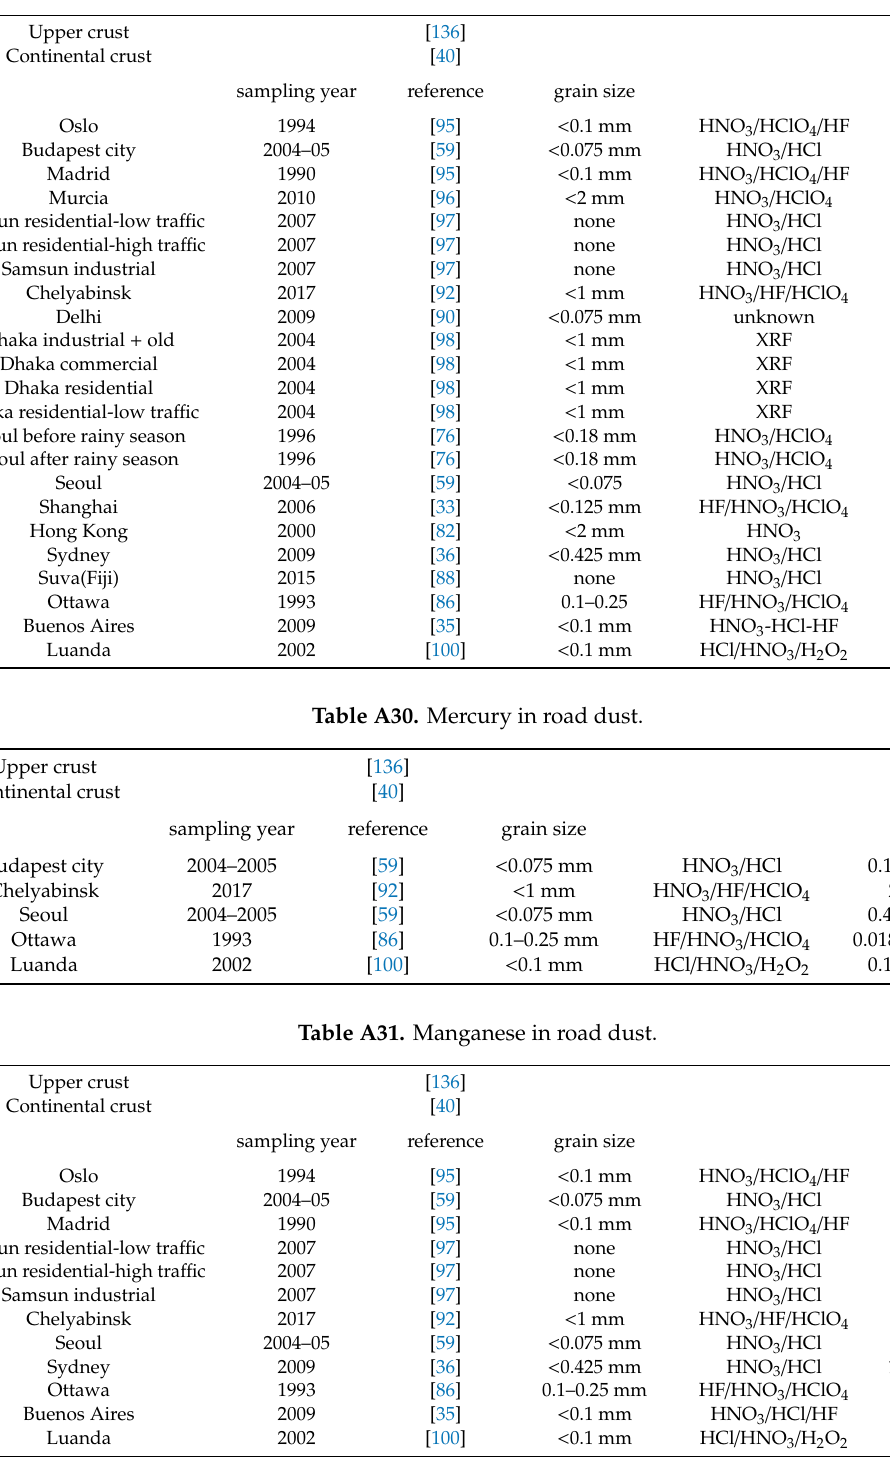
Table A29. Copper in road dust.